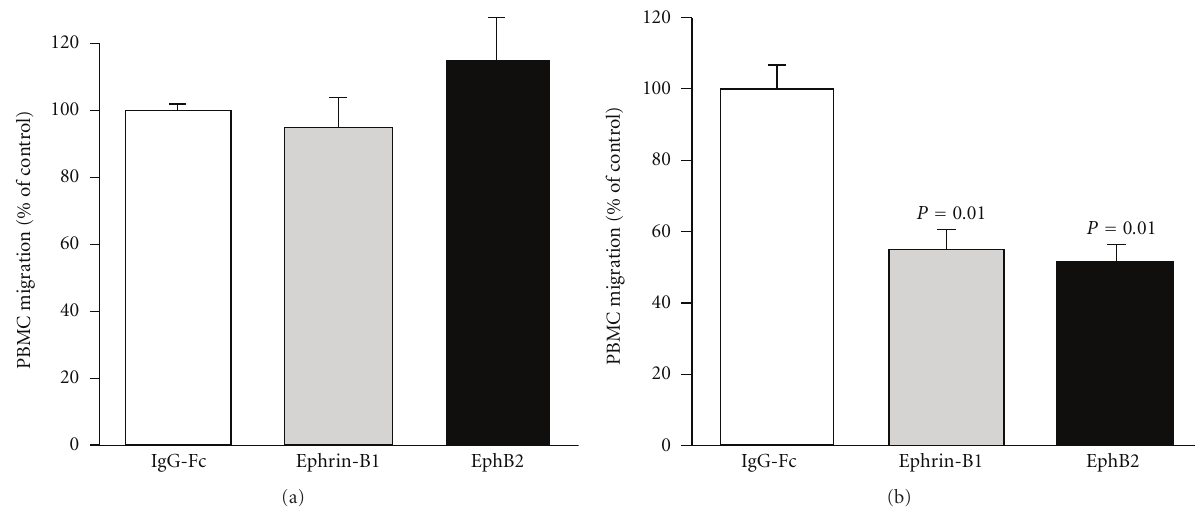
Figure 5: Modulatory e ff ects of ephrin-B1 and EphB2 on transmigration of human PBMC by SDF-1. Boyden chamber assay was performed. (a) E ff ect of ephrin-B1 or EphB2 on spontaneous transmigration. The number of cells migrating into the well without SDF-1 was considered spontaneous transmigration. (b) E ff ect of ephrin-B1 or EphB2 on SDF-1-induced transmigration. With SDF-1, the increased number of cells migrating into the well was due to SDF-1-dependent transmigration. The level of PBMC migration with IgG-Fc used as control, which was 3.6% (a) and 18.5% (b) of inputs (1 × 10 5 cells), was set at 100% for analysing the e ff ect of ephrin-B1 or EphB2. Ephrin-B1, ephrin-B1-IgG- Fc; EphB2, EphB2-IgG-Fc. The results are mean ± SEM ( n = 6) and were analysed by one factor ANOVA and Dunnett’s test compared with IgG-Fc